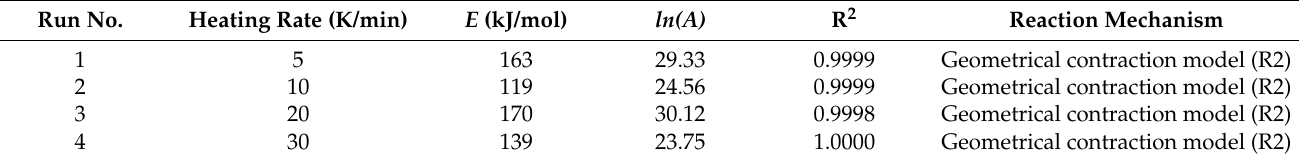
Table 11. Kinetic parameters of the PLA pyrolysis obtained by the Coats–Redfern model. Run